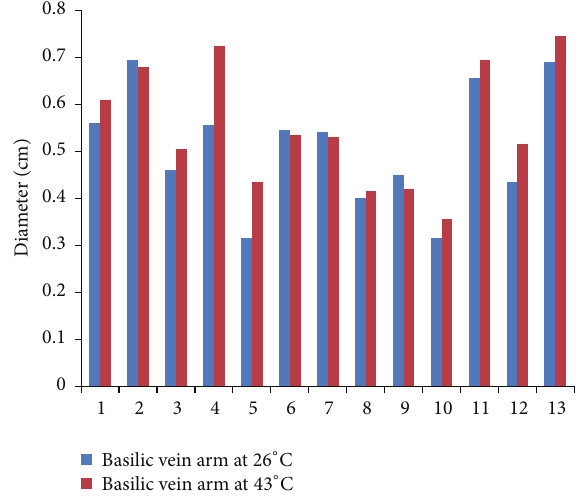
Figure 3: Diameter of basilic vein at